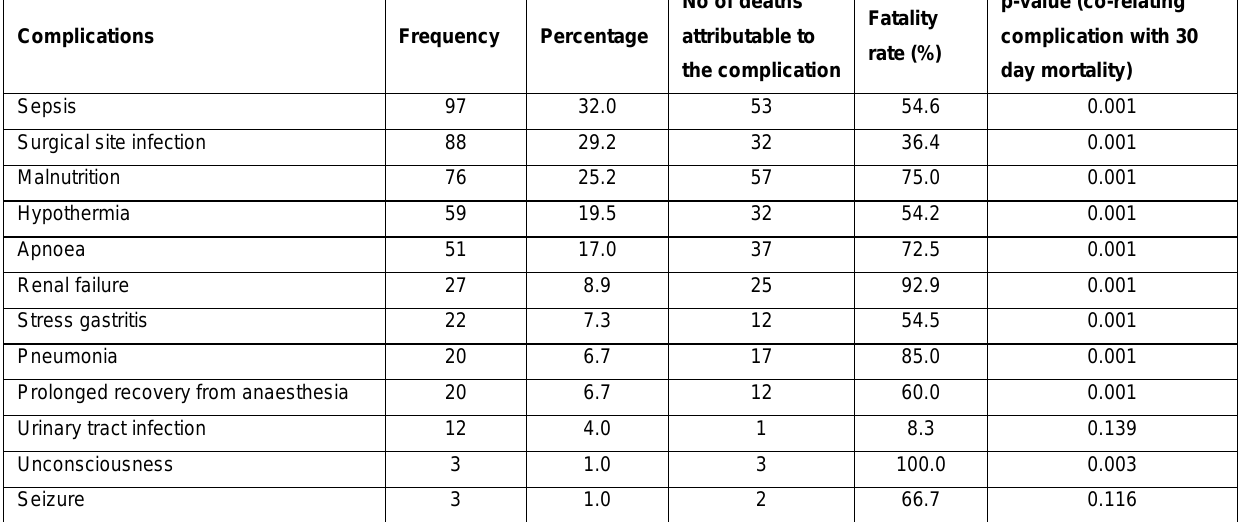
Table 3: Post-operative complications, fatality rates from the complications and correlation with 30-day